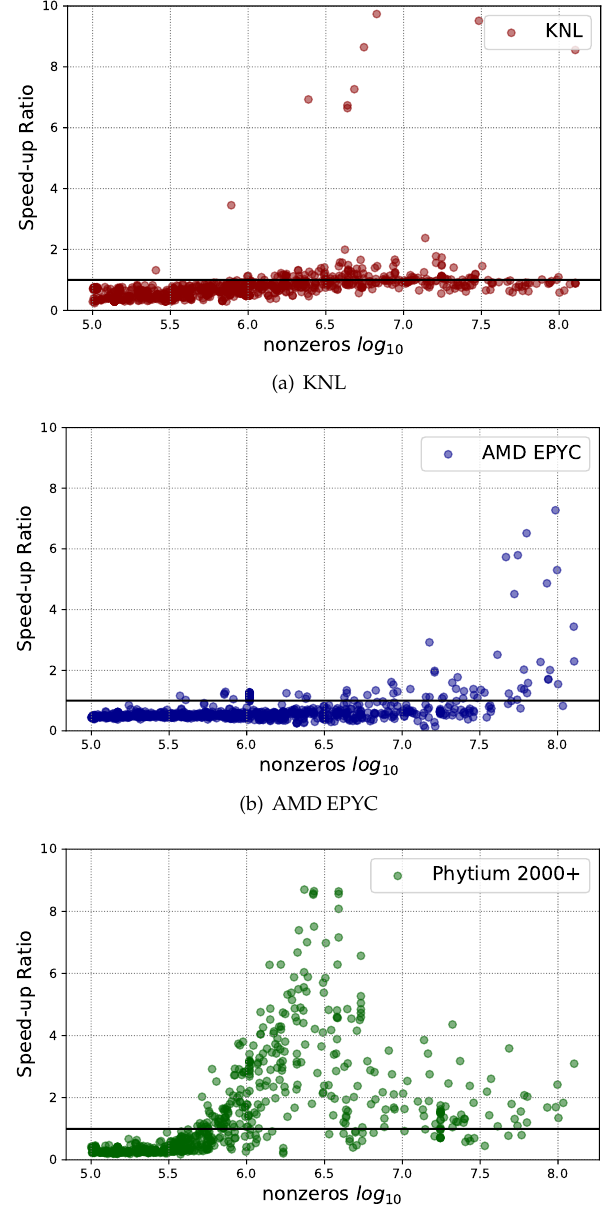
Figure 10. The scatter diagrams show the speedup ratio of performance of HYB5-based SpMV with the optimal K and the optimal performance from using the other compared formats for each matrix on three target